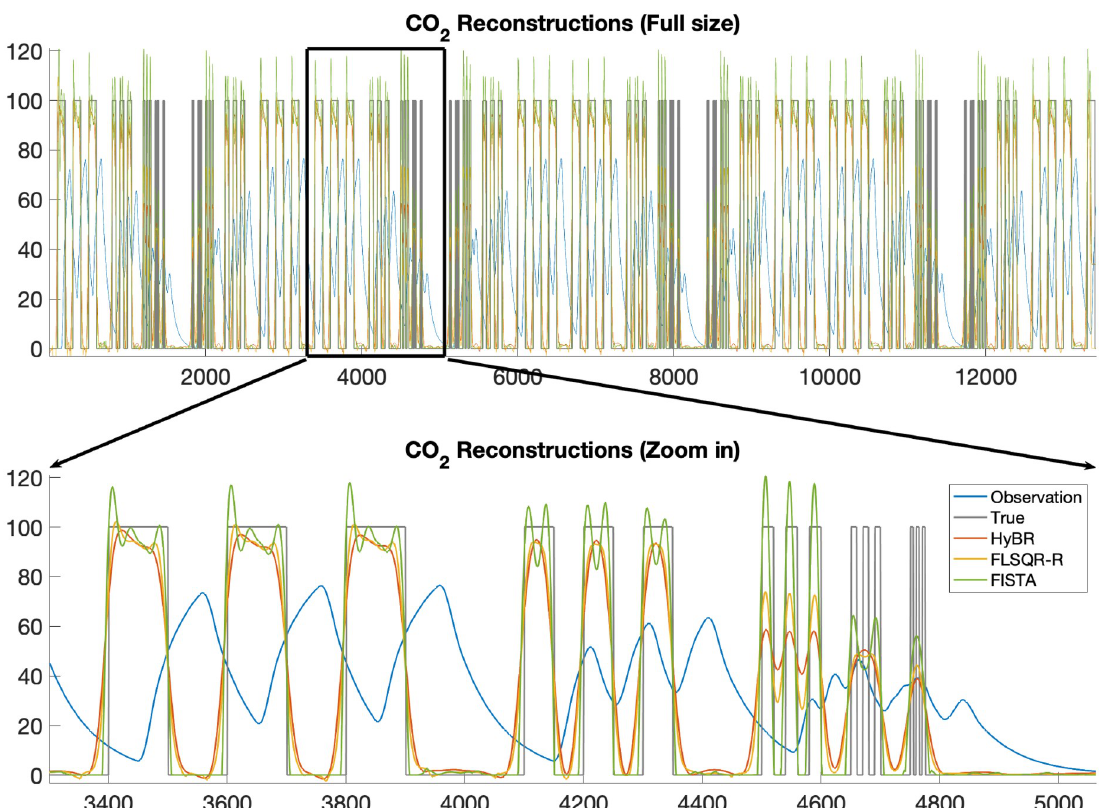
Fig 12. Experimental results for linear case study. Reconstruction of input CO 2 signal using different reconstruction methods. A zoomed plot is provided in the bottom plot.